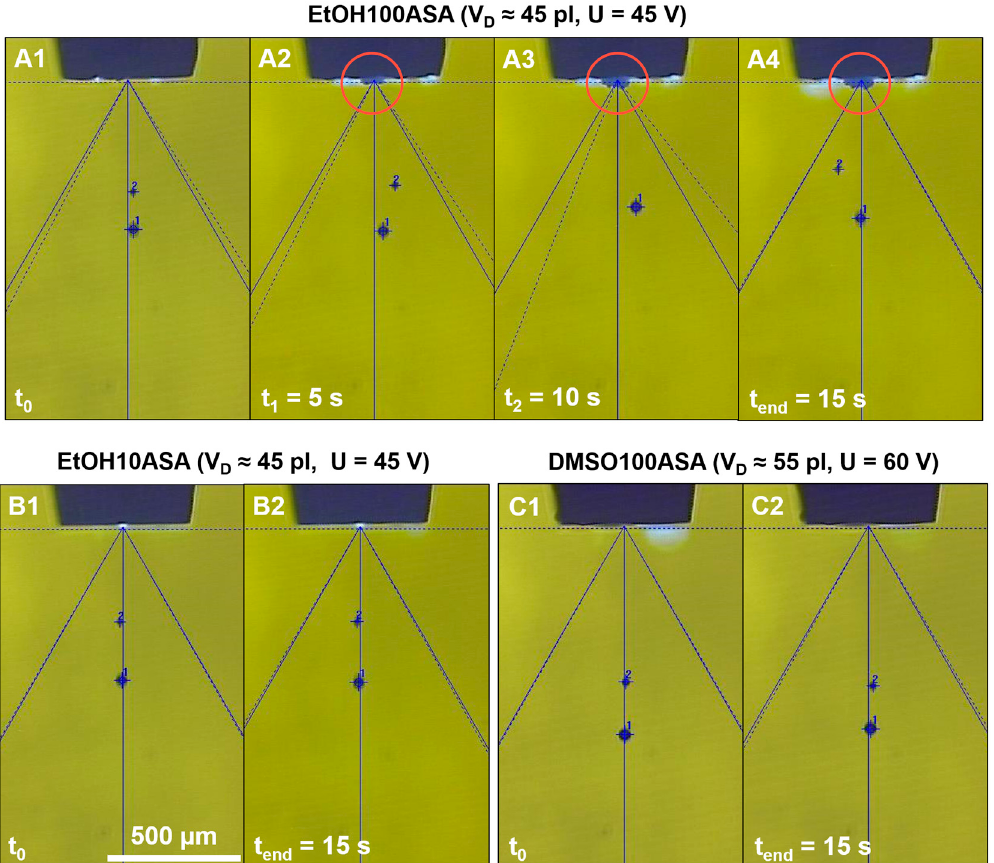
Figure 2. Exemplary stroboscopic image capturing system photographs of droplet formation of the drug solutions EtOH100ASA ( A1 – A4 ), EtOH10ASA ( B1 , B2 ) and DMSO100ASA ( C1 , C2 ) over time of the investigation. Droplet formation of EtOH100ASA is interfered, as there is a steady growth of drug deposits on the nozzle (circled red). For EtOH10ASA and DMSO100ASA there are no notable drug deposits and a highly reproducible droplet formation.